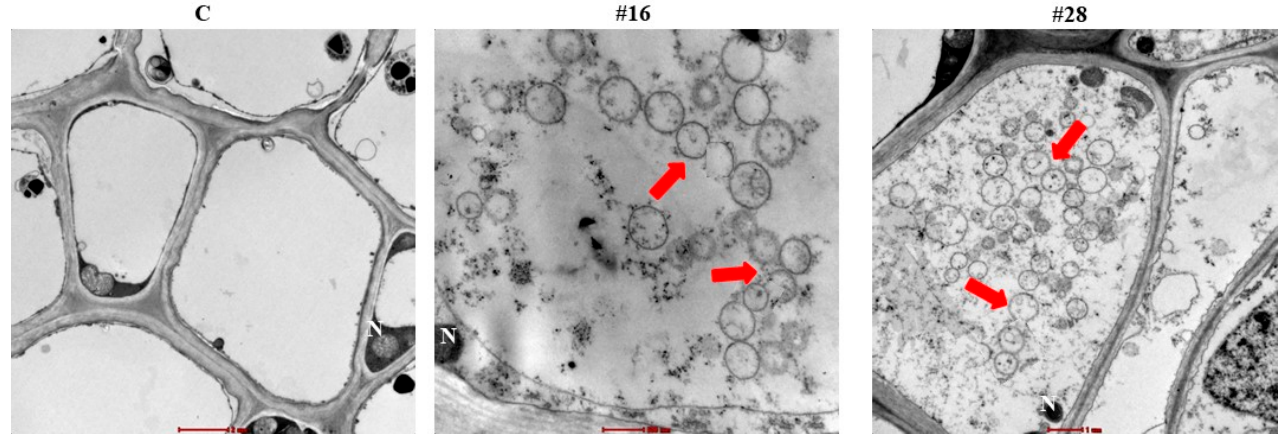
Figure 3. Intercellular colonization of date palm root tissues by the endophytic BCAs. Transmission electron micrograph of ultra-thin sections of date palm root tissues of non-inoculated control (C; left; 6000X) and inoculated with isolate #16 (BCA1; middle; 20,500X) or #28 (BCA2; right; 11,500X). All sections were stained with uranyl acetate and lead citrate showing the distribution of spore chains (red arrows). Bars: 2 µm ( left ); 500 nm ( middle ); 1 µm ( right ). Isolates #16 and #28 represent Streptomyces polychromogenes UAE2 and Streptomyces coeruleoprunus UAE1, respectively. BCA, biological control agent; N, nucleus.